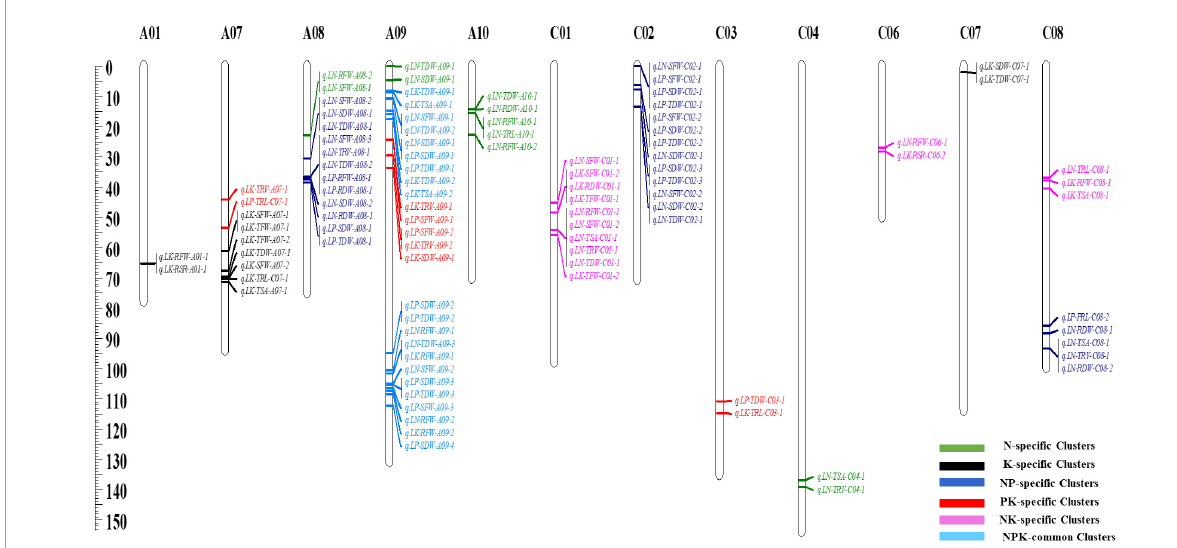
FIGURE4 Information of quantitative trait loci (QTL) clusters in recombinant inbred line (RIL) population under LN/LP/LK conditions.